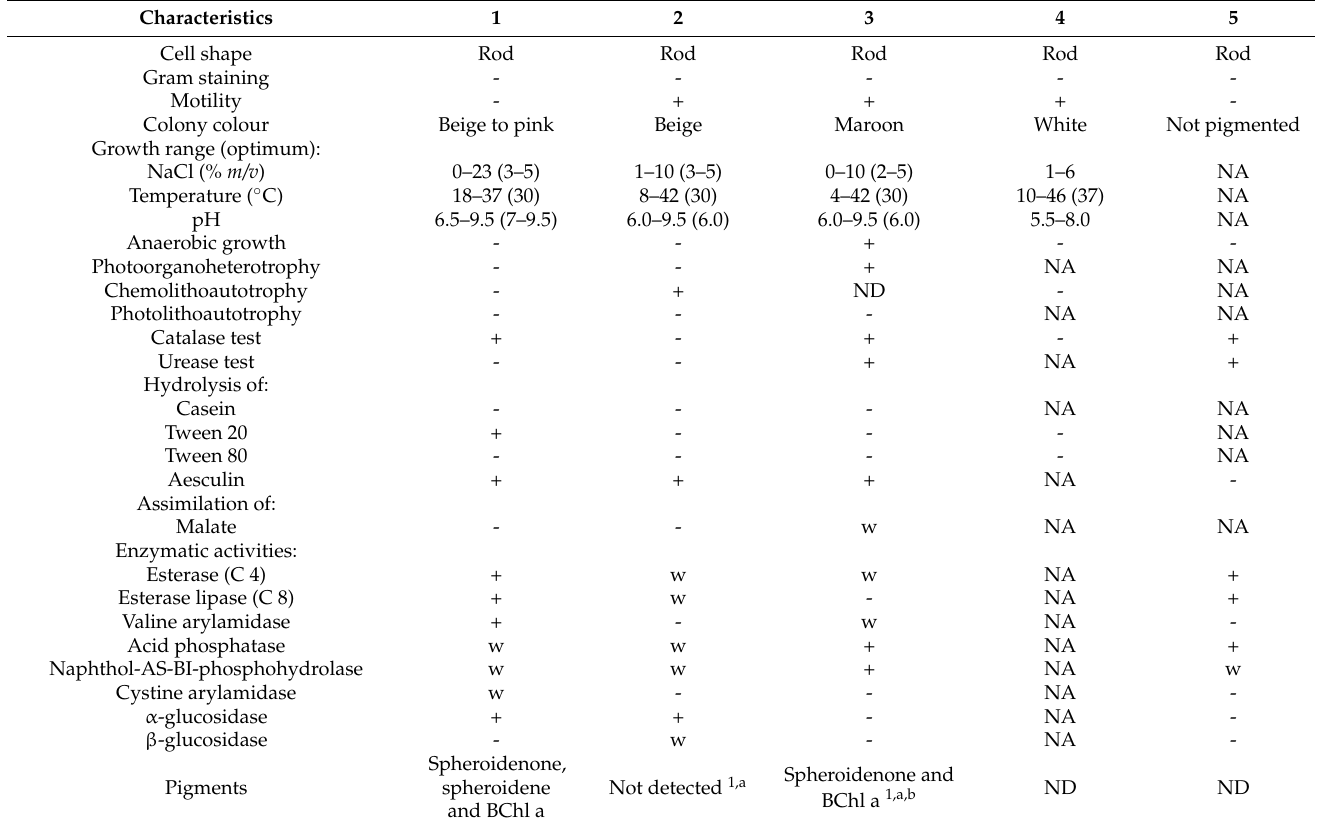
Table 1. Major phenotypic characteristics that distinguished ASV31 T from its closest relatives. Strains: 1, ASV31 T (this study); 2, Thioclava pacifica DSM 10166 T (this study); 3, Rhodovulum algae LMG 29228 T (this study); 4, Tropicimonas isoalkanivorans B51 T [40]; 5, Haematobacter massiliensis CCUG 47968 T [41]. +, positive; − , negative; w, weakly positive; NA, no data available; ND, not determined. All the strains were positive for oxidase. In API ZYM strips, all the strains were positive for alkaline phosphatase, leucine arylamidase and negative for lipase (C 14), trypsin, α -chymotrypsin, α -galactosidase, β - galactosidase, β -glucuronidase, N-acetyl- β -glucosaminidase, α -mannosidase and α -fucosidase.